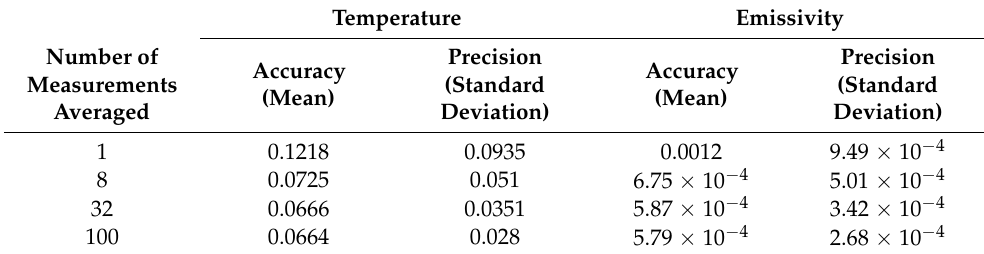
Table 2. Validation of calibration accuracy and